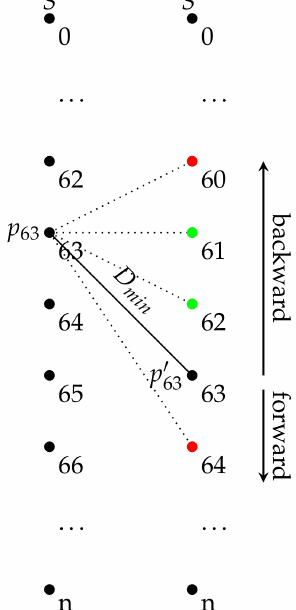
Figure 4. Visualisation of the right neighbour calculation for the point p 63 , which is the point with index 63 in a scan line S: The search starts at the adjacent point p (cid:48) , which is the point with the same index in 63 the adjacent scan line S’. The distance between these two points is the initial distance D min . A forward and backward search is then initiated. Green dots mean that the distance is lower than the previous one and that the point is taken as the candidate neighbour. Red dots mean that the distance is higher than the previous one and that the search in that direction ends. After the actual process, the point in the adjacent scan line S (cid:48) yielding the minimum distance to p 63 is selected as the right neighbour, which is p (cid:48) in this 61